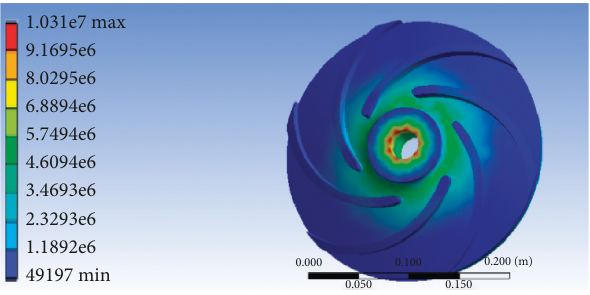
Figure 12: Cloud diagram of stress distribution. Table 6: Orthogonal experimental factors of lining pump impeller level